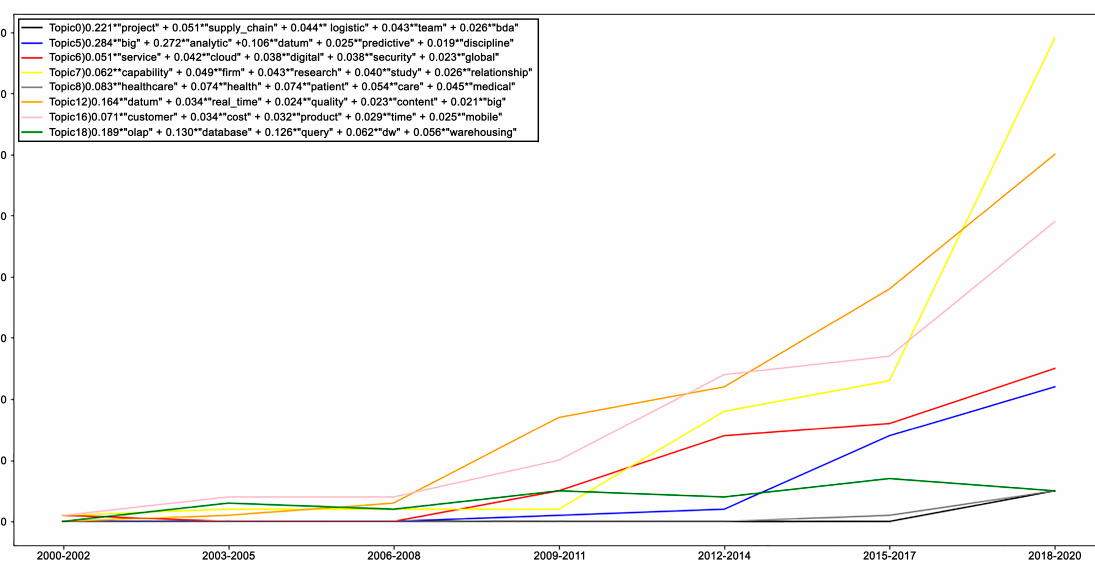
Figure 16. Graph of the pattern of behavior of the main topics discovered.